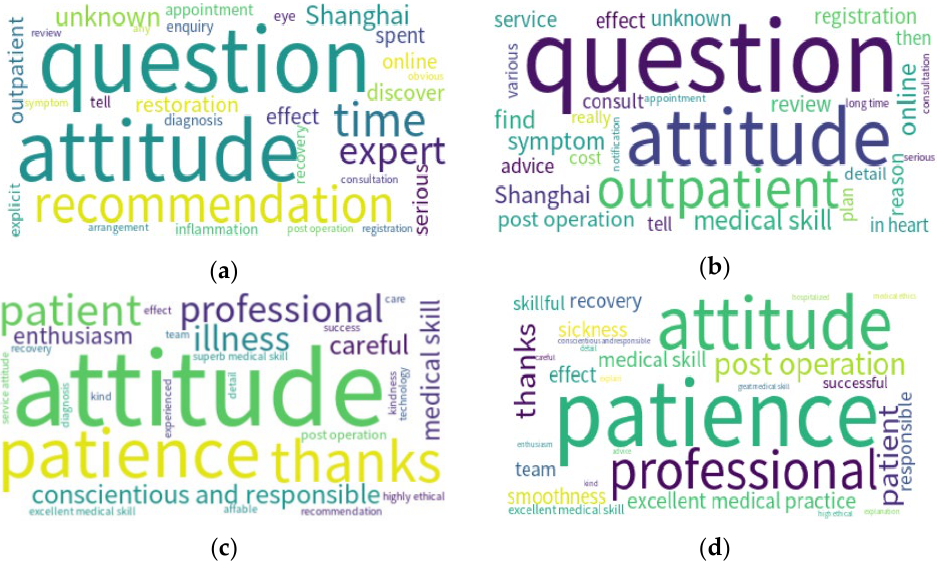
Figure 2. Doctor reviews from Shanghai: ( a ) negative before the pandemic, ( b ) negative during the pandemic, ( c ) positive before the pandemic and ( d ) positive during the pandemic.